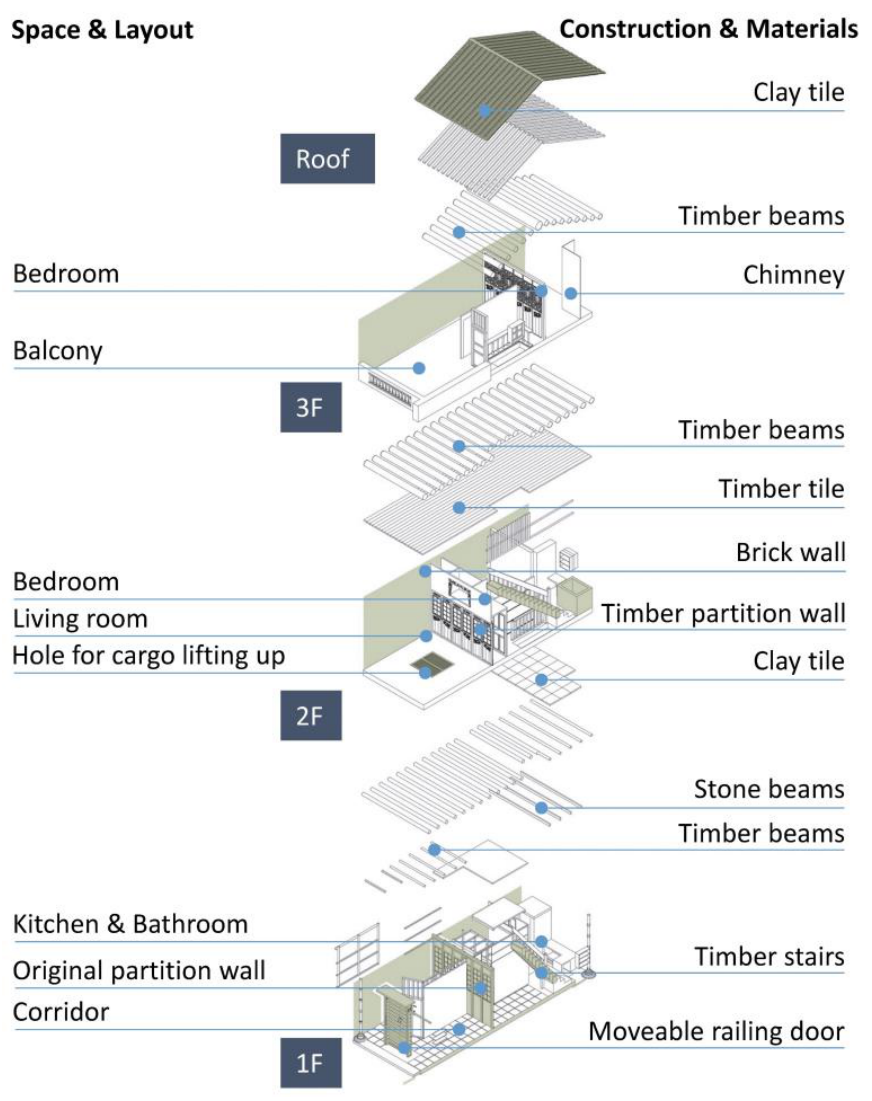
Figure 10. Space and construction of the study house (drawn by the students).